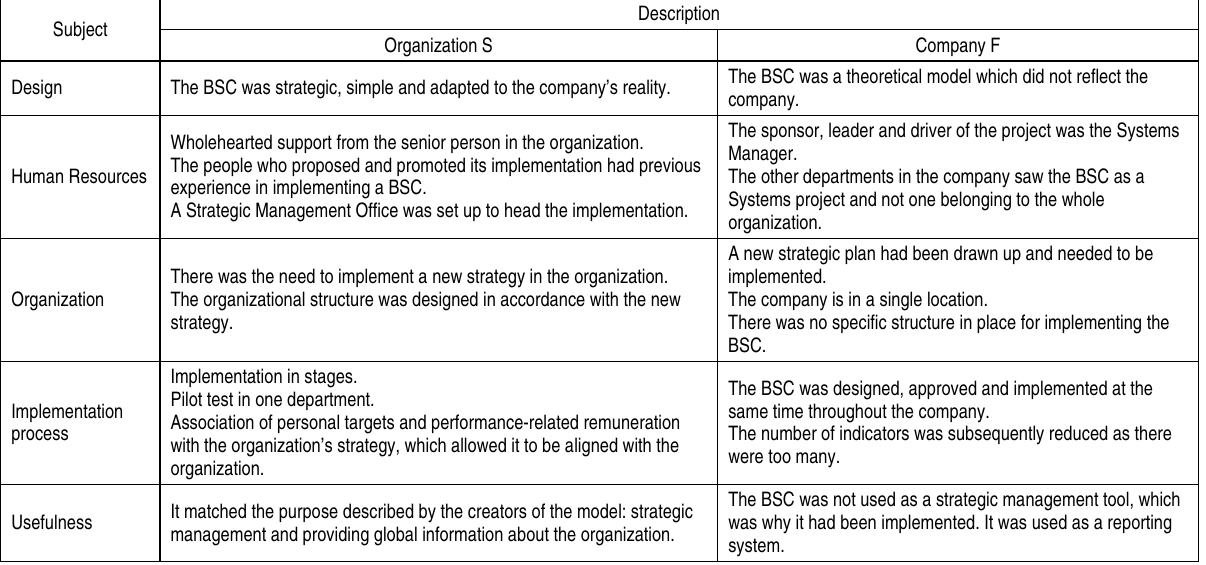
Table 2. Comparison of the main characteristics in the implementation of the BSC